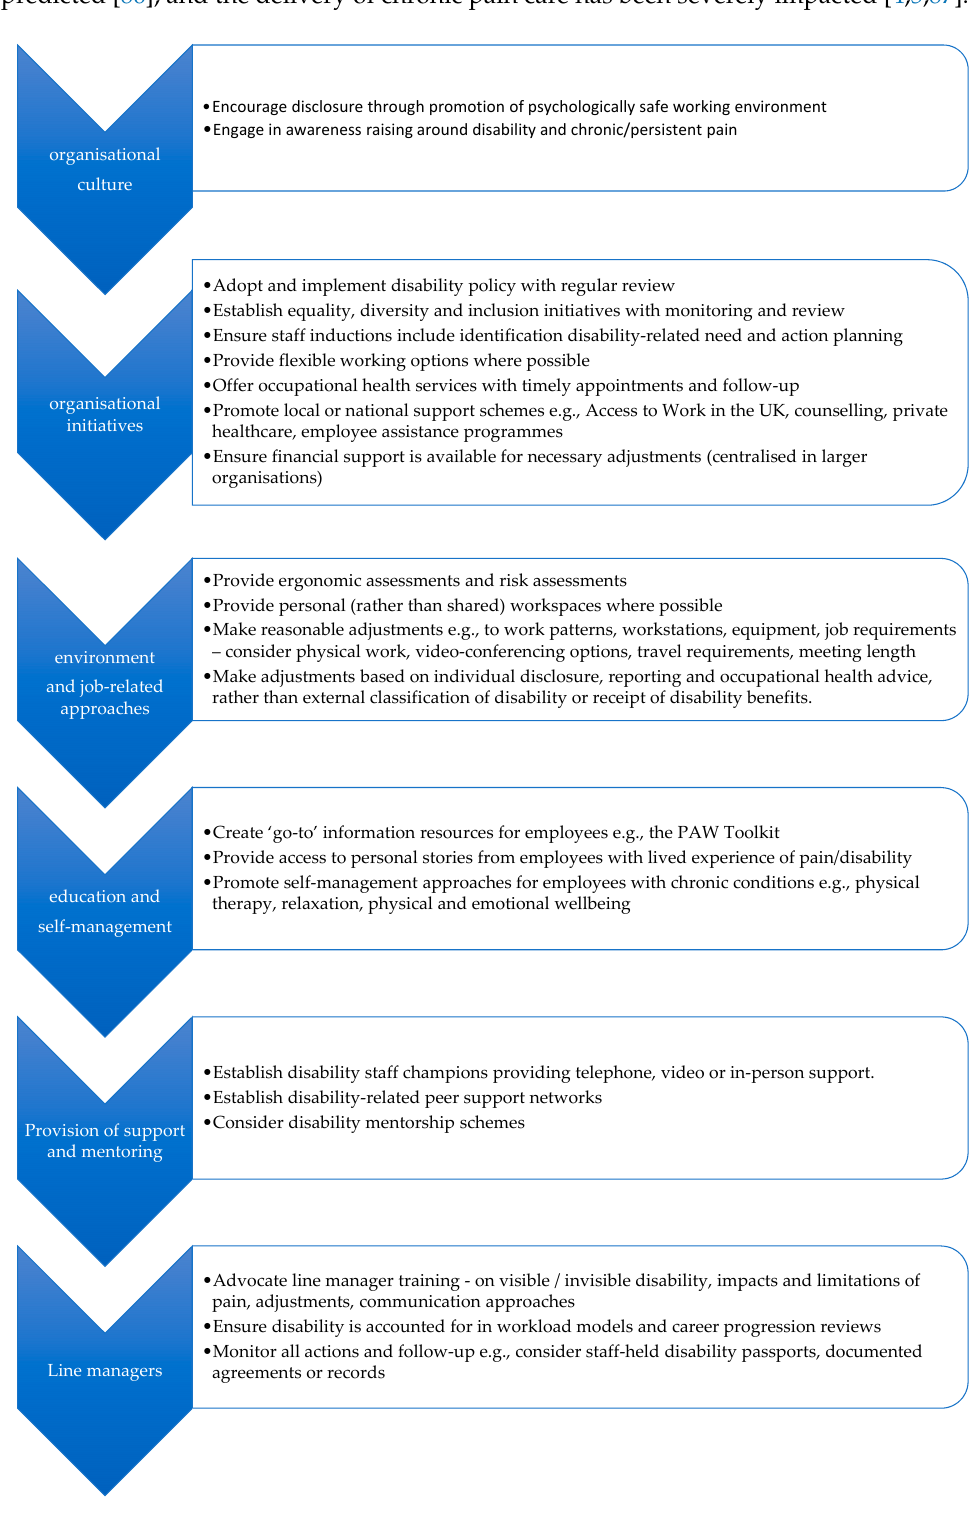
Figure 5. Proposed approaches to support employees with chronic or persistent pain.